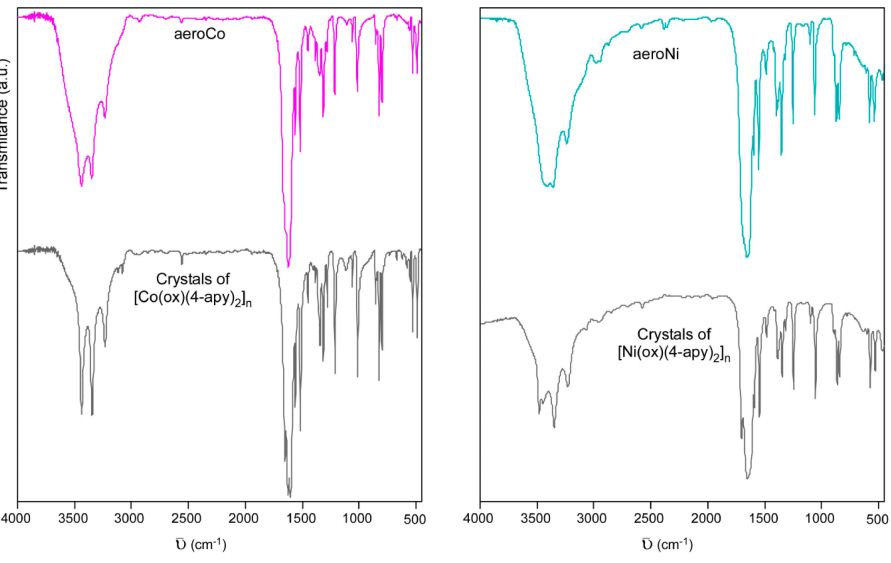
Figure 3. FTIR spectra for Co(II) and Ni(II) aerogels and crystals of [M(ox)(4-apy) 2 ] n (M(II): Co,